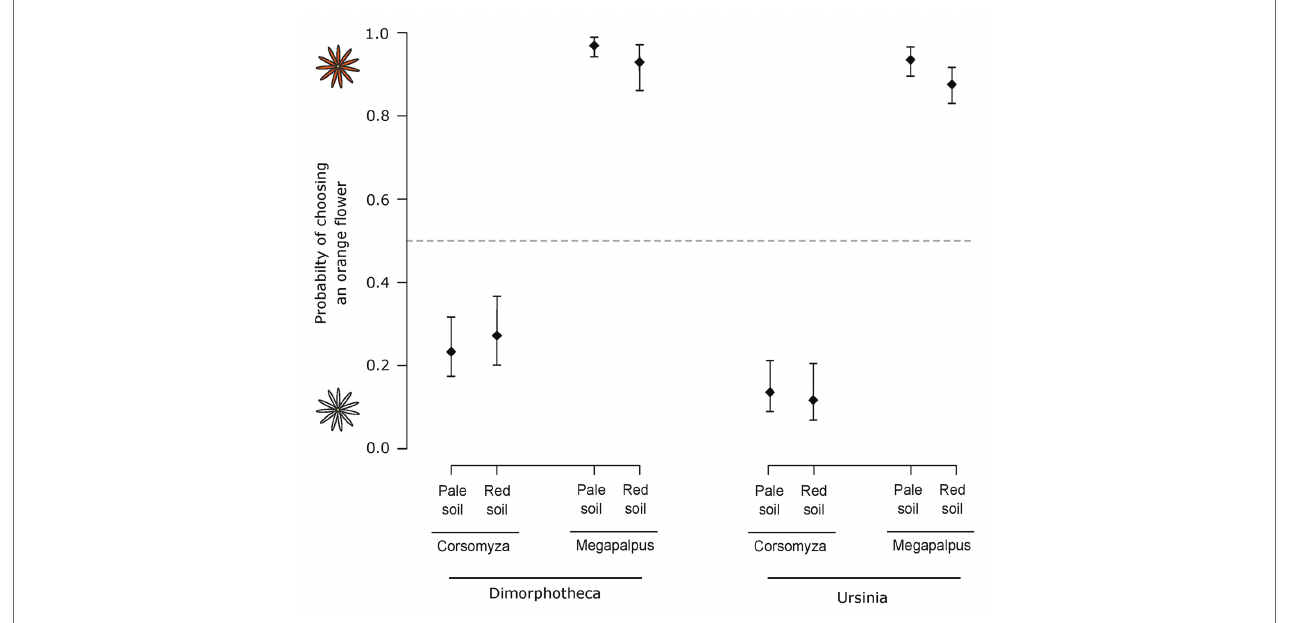
FIGURE 5 | The probability of pollinating flies ( Corsomyza nigripes and Megapalpus capensis ) choosing an orange flower over a white flower. Experiments tested fly color preferences using orange-white species pairs of Dimorphotheca (orange Dimorphotheca sinuata vs. white Dimorphotheca pluvialis ) and Ursinia (orange Ursinia cakilefolia vs. white Ursinia speciosa ) presented on both red and pale soils. Megapalpus capensis preferred orange flowers and Corsomyza nigripes preferred white flowers of both daisy genera, irrespective of the